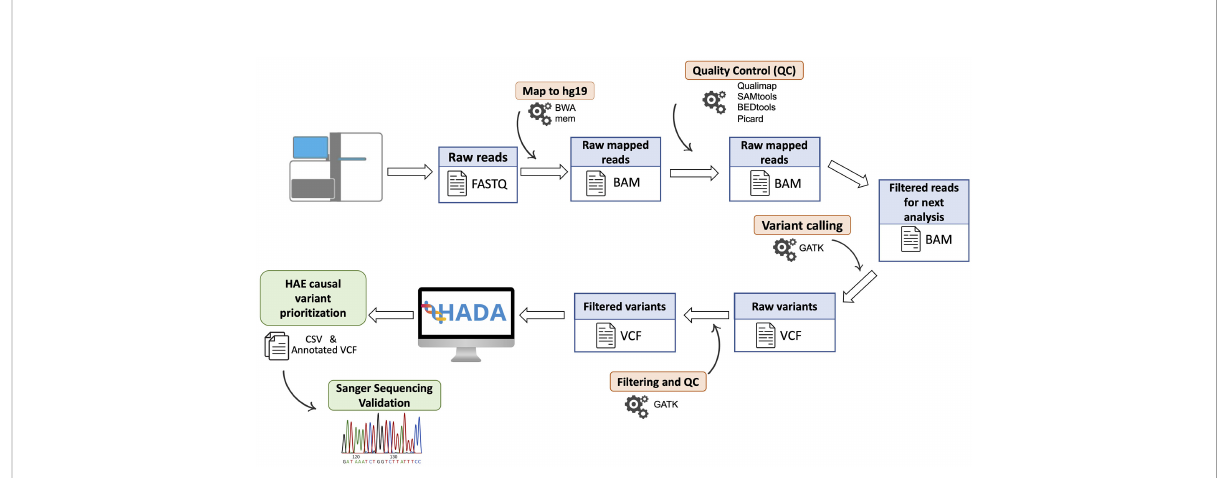
FIGURE 1 Schematic representation of the steps followed for patient DNA sequencing data. Algorithms are shown in orange and processed fi les in blue. The HAE causal variants prioritized by HADA and the Sanger validation step are shown in